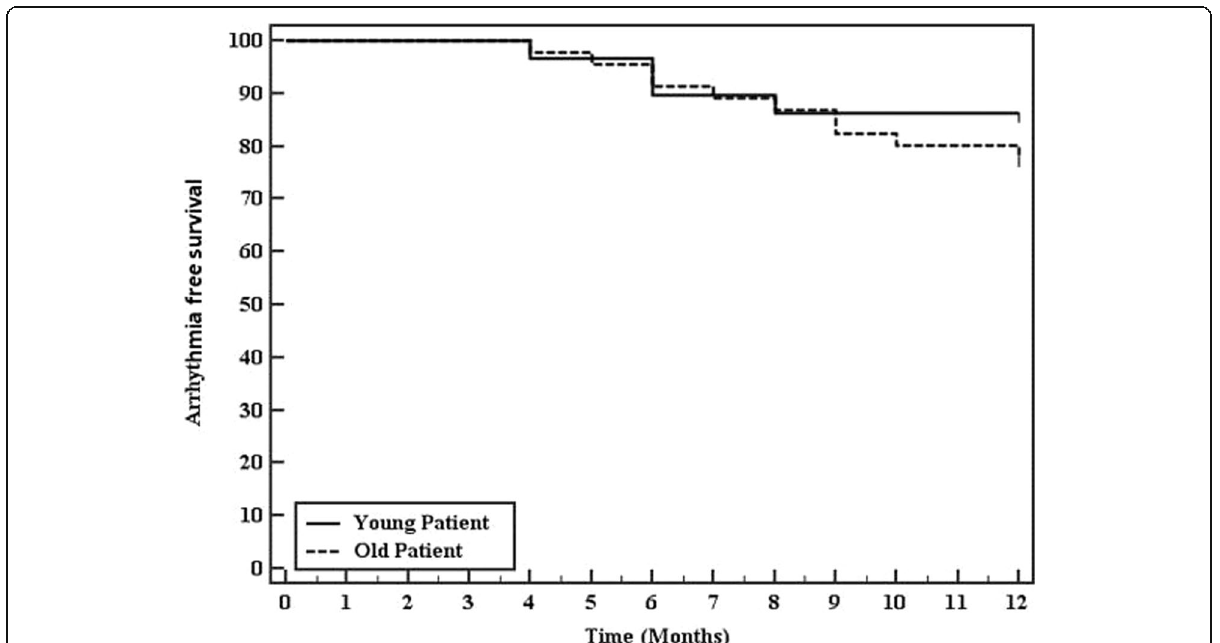
Fig. 3 The Kaplan-Meier estimate arrhythmia-free survival and 95% confidence intervals after RF ablation of PAF in the young group (continuous line) and old group (dashed line) over 1 year. Numbers indicate remaining patients without AF recurrence at each time